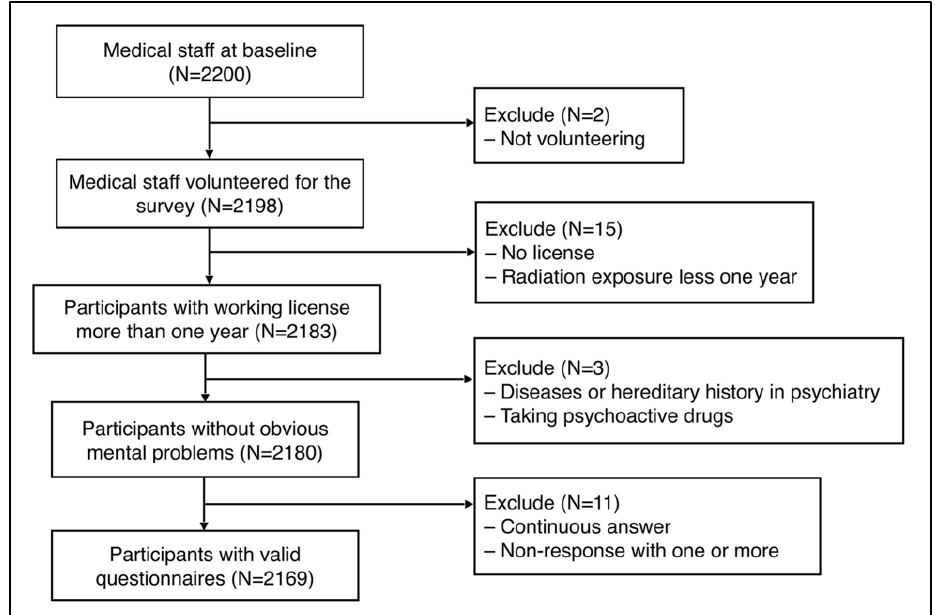
Figure 1. Definition of the study